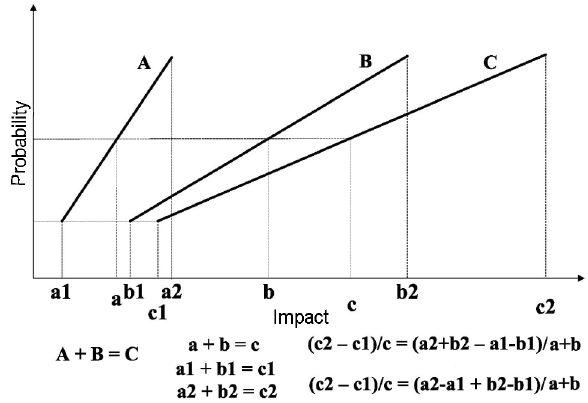
Fig. 7 . Summing up of two cumulative